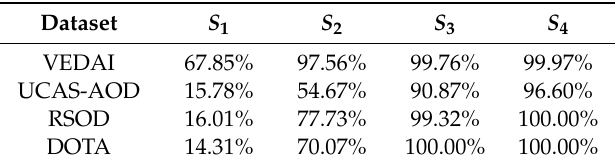
Table 2. The proportion of objects with di ff erent scales to all targets in each